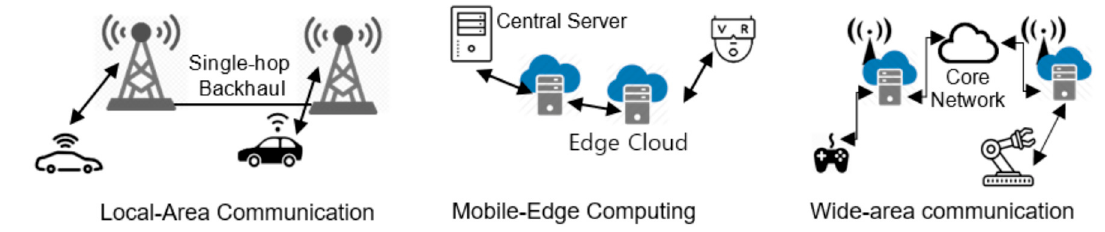
Figure 12. Three communication solutions for URLLC quality of service (QoS) requirements. Table 8. Research towards the improvement of MEC with URLLC.